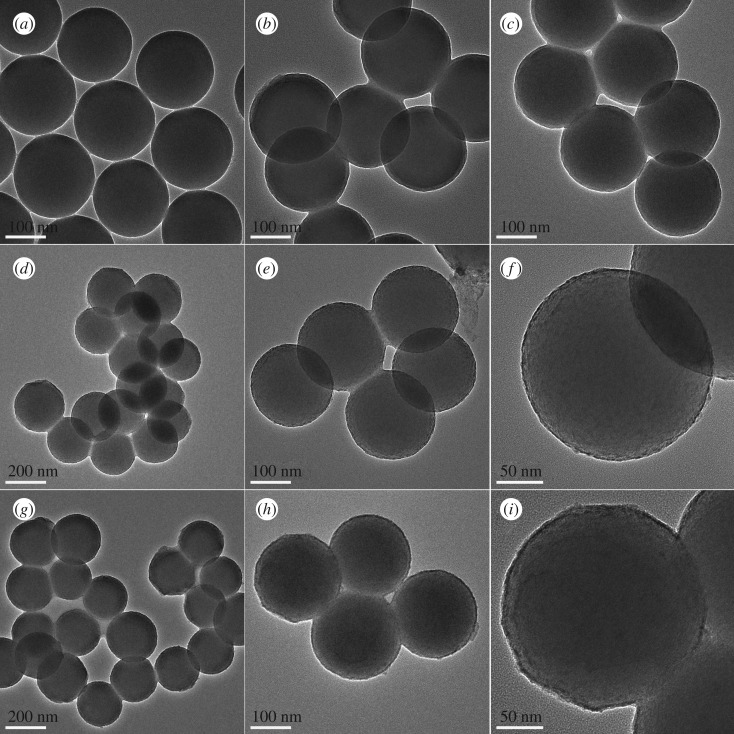
TEM images of the products synthesized in different stages: (a) SiO2, (b) SiO2@NH2, (c) SiO2@MAH-Si, (d–f) SiO2@MAH-Si-Gd:Tb, (g–i) SiO2@GdPO4:Tb.